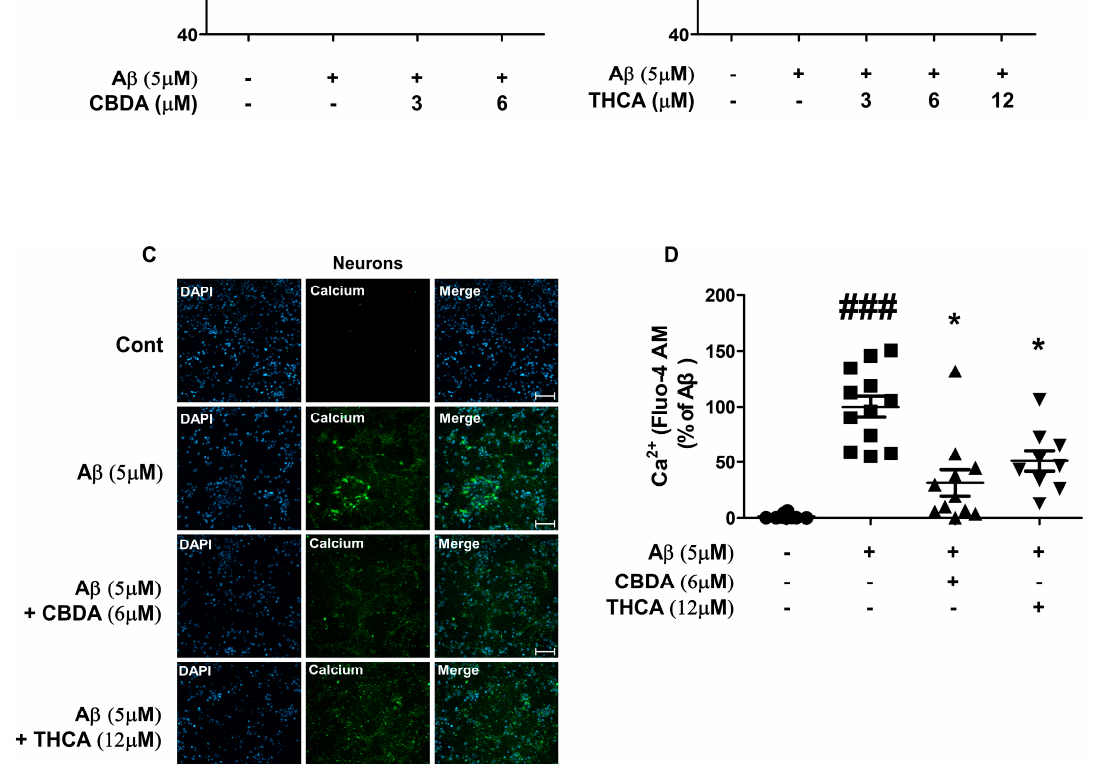
Figure 1. Effects of CBDA and THCA on neuroprotection and Ca 2+ levels in primary neurons. Neu- roprotective effect of ( A ) CBDA and ( B ) THCA. ( C ) Representative fluorescence images of Fluo-4 AM-positive Ca 2+ . Nuclei were stained using DAPI. Scale bar = 100 µm. ( D ) Fluorescence Ca 2+ intensities. (mean ± SEM, ### p < 0.001 vs. PBS-treated, * p < 0.05, ** p < 0.005, and *** p < 0.001 vs. A β 1-42 -treated, one-way ANOVA followed by Fisher’s LSD; n = 3 per group).